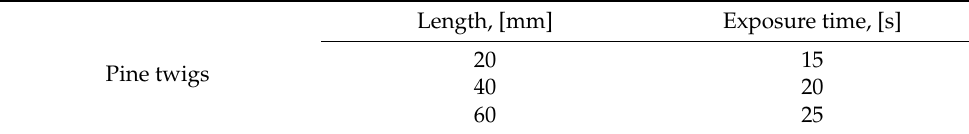
Figure 3. Photo of the sample before the experiment. Table 2. Exposure time depended on firebrand